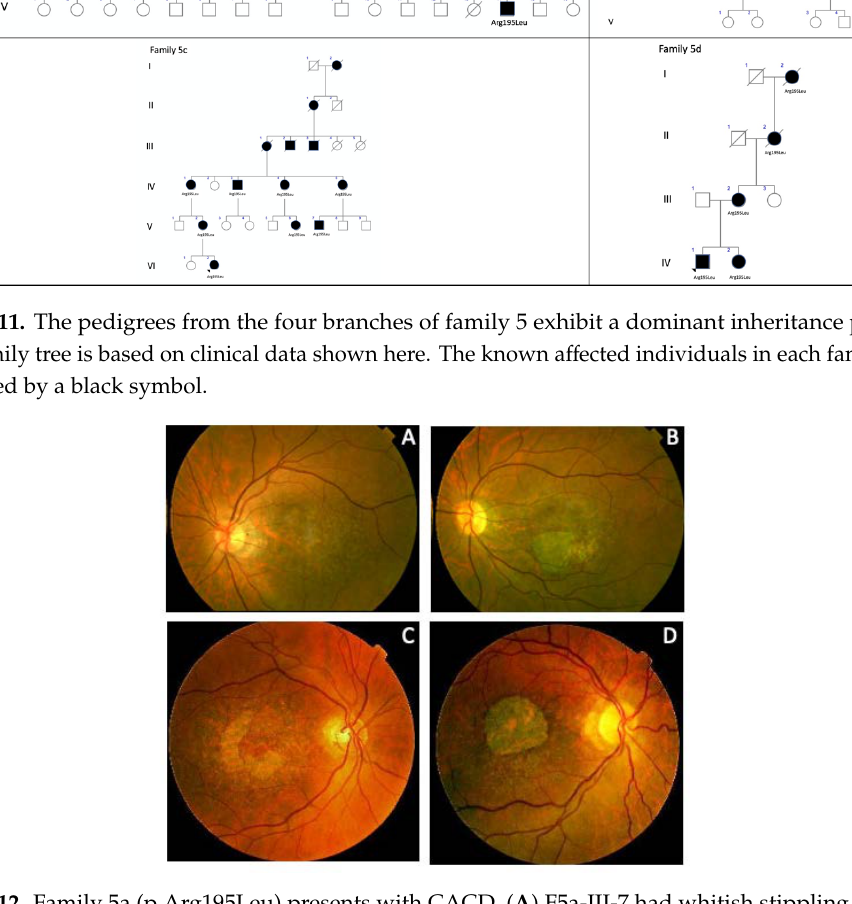
Figure 13. The clinical appearance of family 5b (p.Arg195Leu). F5b-III-4 had ( A ) a large area of atrophy in the posterior pole and ( B ) extensive atrophy in the mid-periphery. The least affected patient was F5b-IV-2 with mild macular changes in the ( C ) fundus and ( D ) AF. F5b-IV-1 had clear macular atrophy in ( E ) the fundus and ( F ) AF. ( G ) F5b-IV-4 had atrophy in the posterior pole and mid-periphery, outer retinal atrophy (red brace and red arrow) was much more evident in the ( H ) SD-OCT and ( I ) autofluorescence images, and ( J ) extension of atrophy to the mid-periphery was evident in the fluorescein angiogram.